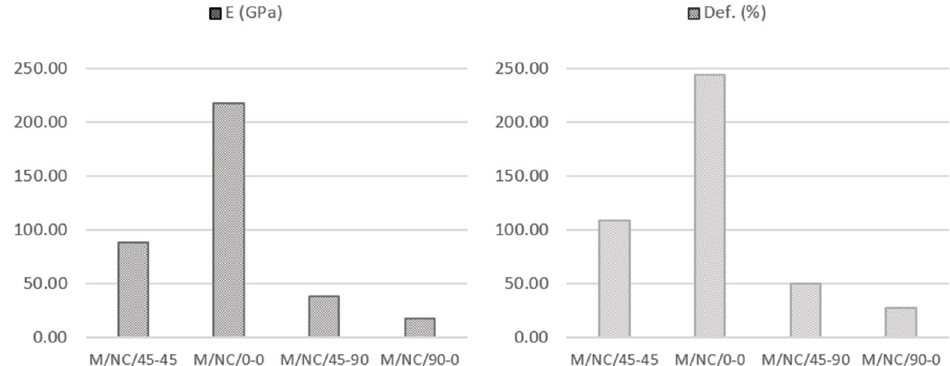
Figure 21. Nylon + Carbon Fiber specimens’ parameters average value.